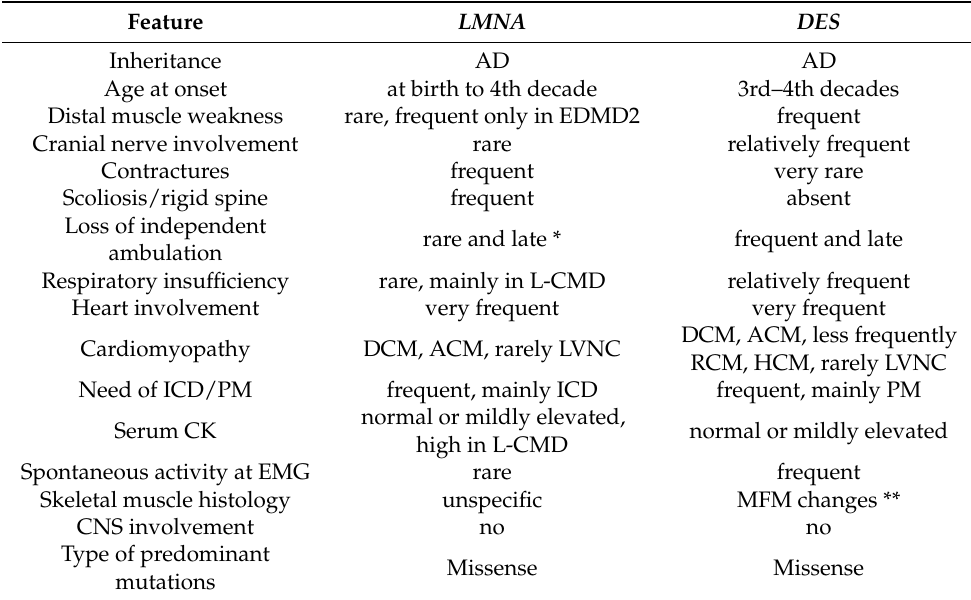
Table 1. Clinical features of LMNA or DES -related striated muscle